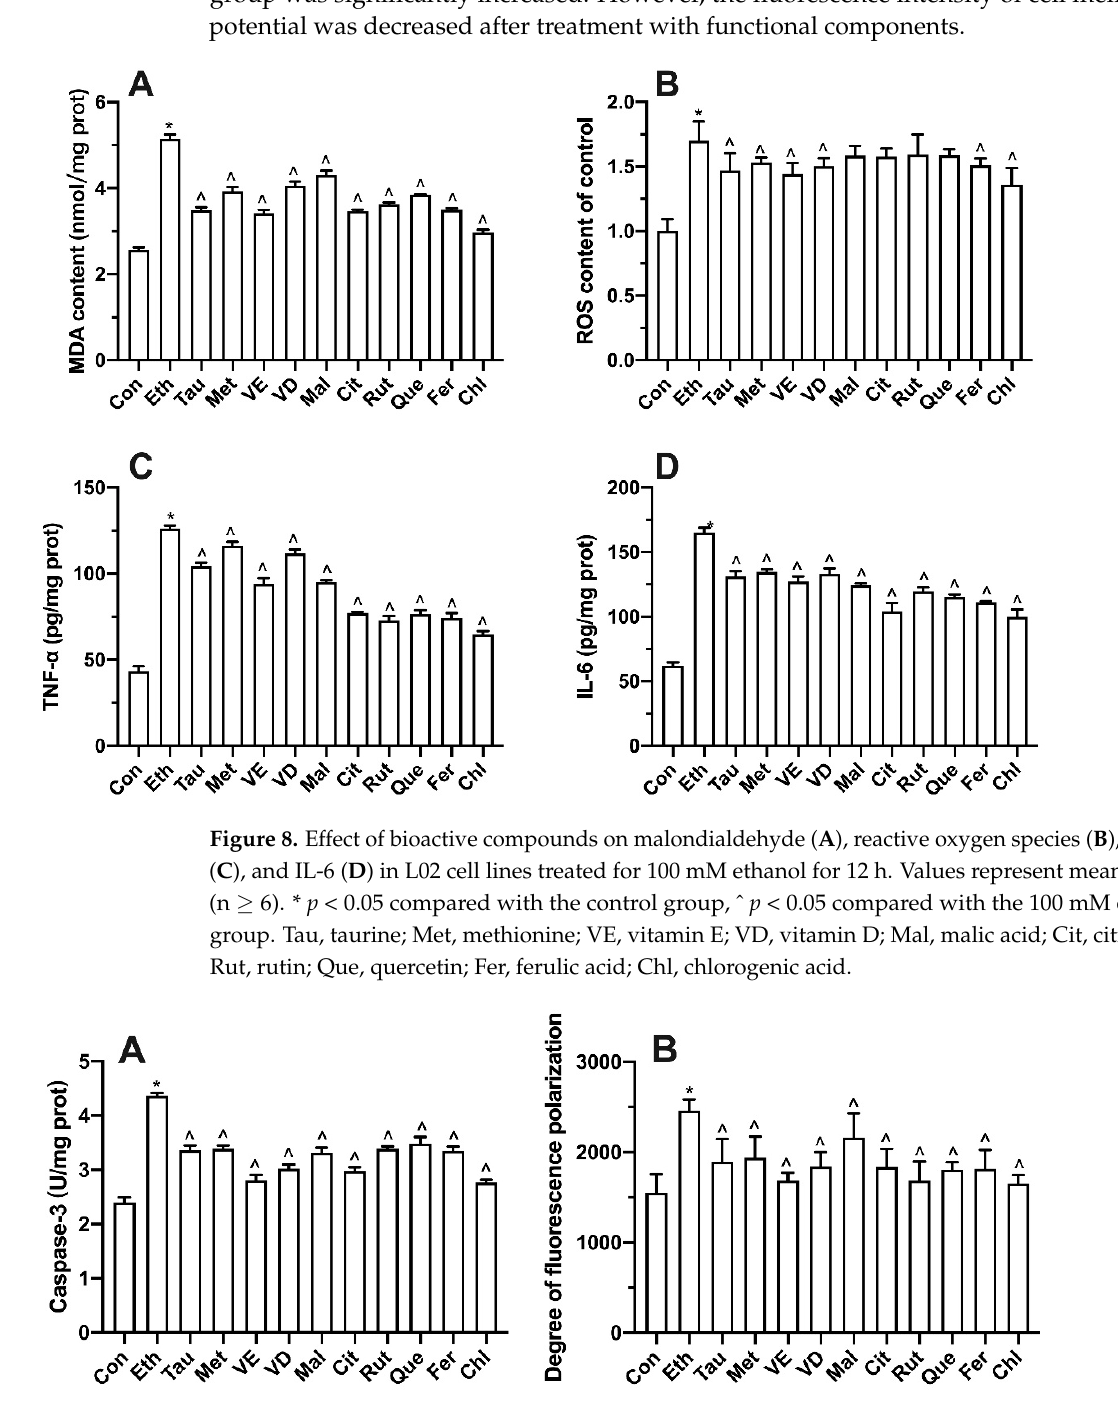
Figure 9. Effect of bioactive compounds on caspase 3 ( A ) and degree of fluorescence polarization ( B ) in L02 cell lines treated for 100 mM ethanol for 12 h. Values represent means ± SD (n ≥ 6). * p < 0.05 compared with the control group, ˆ p < 0.05 compared with 100 mM ethanol. Tau, taurine; Met, methionine; VE, vitamin E; VD, vitamin D; Mal, malic acid; Cit, citric acid; Rut, rutin; Que, quercetin; Fer, ferulic acid; Chl, chlorogenic